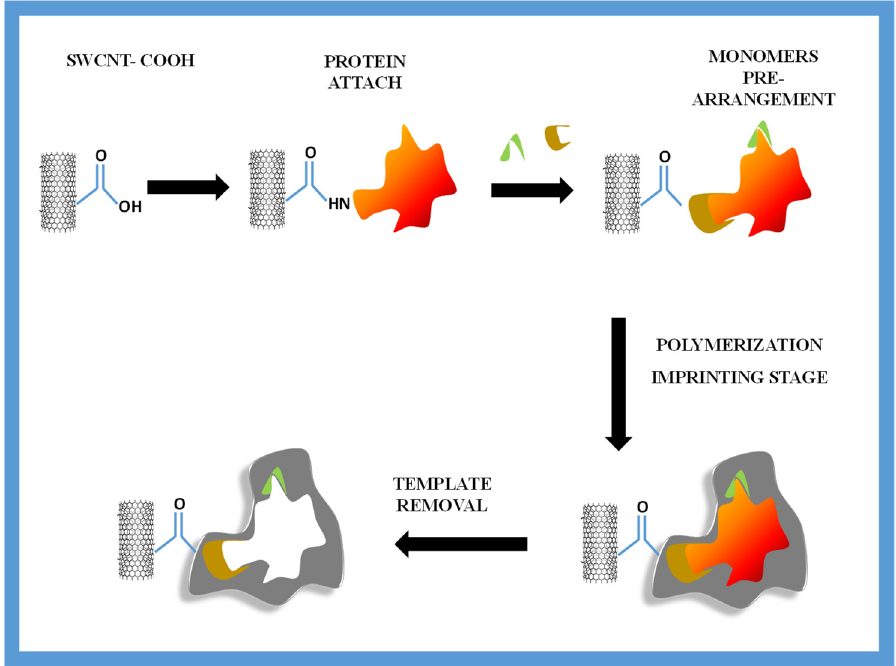
Figure 1. Synthesis of the plastic antibody.